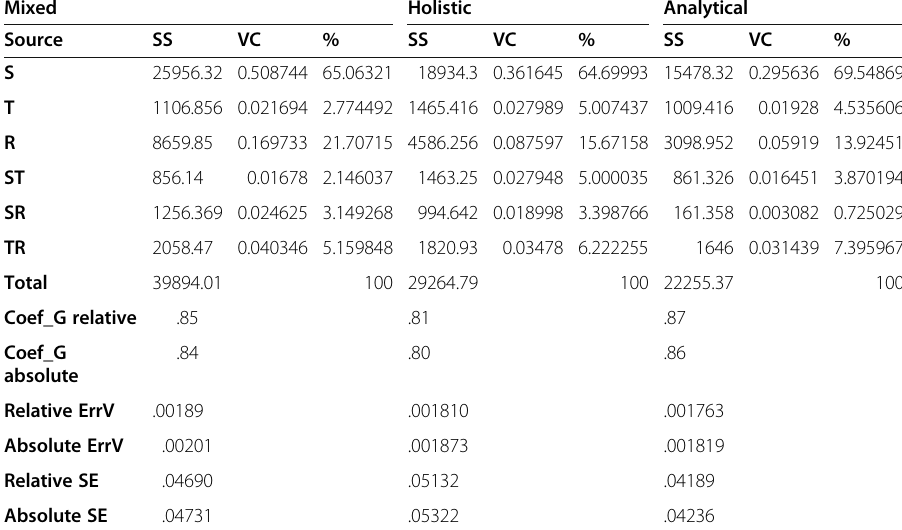
Table 7 G-study (method of scoring) Mixed Holistic